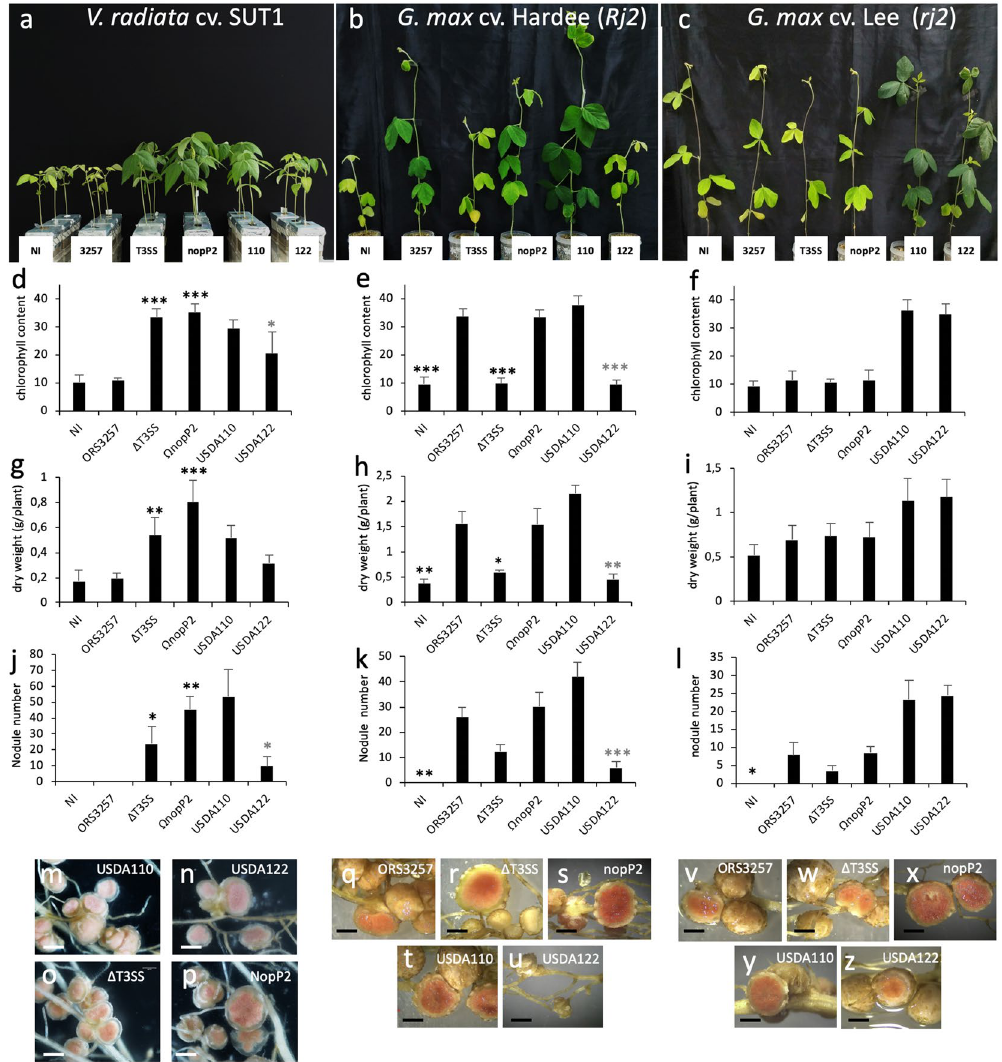
Figure 5. Symbiotic properties of various Bradyrhizobium strains in V. radiata cv. SUT1, G. max cv. Hardee ( Rj2 ) and G. max cv. Lee ( rj2 ). ( a – c ) Comparison of the growth of the plants (aerial part), non-inoculated (NI) or inoculated with ORS3257 wild-type strain (3257) or its derivative mutants (∆T3SS and ΩNopP2) or with USDA122 (122) or USDA110 (110) WT-strains at 21 days after inoculation. ( d–f ) Leaf chlorophyll content; ( g – i ) Plant dry weight; ( j–l ) Number of nodules per plant. The experiment was carried out in duplicate with five plants per condition. *P < 0.05, **P < 0.01, and ***P < 0.001. Black asterisks indicate significant differences between WT ORS3257 and other strains tested, using a nonparametric Kruskal–Wallis test, Gray asterisks indicate significant differences between WT USDA110 and WT USDA122. ( m – z ) View of the nodules. (Scale bars, 1